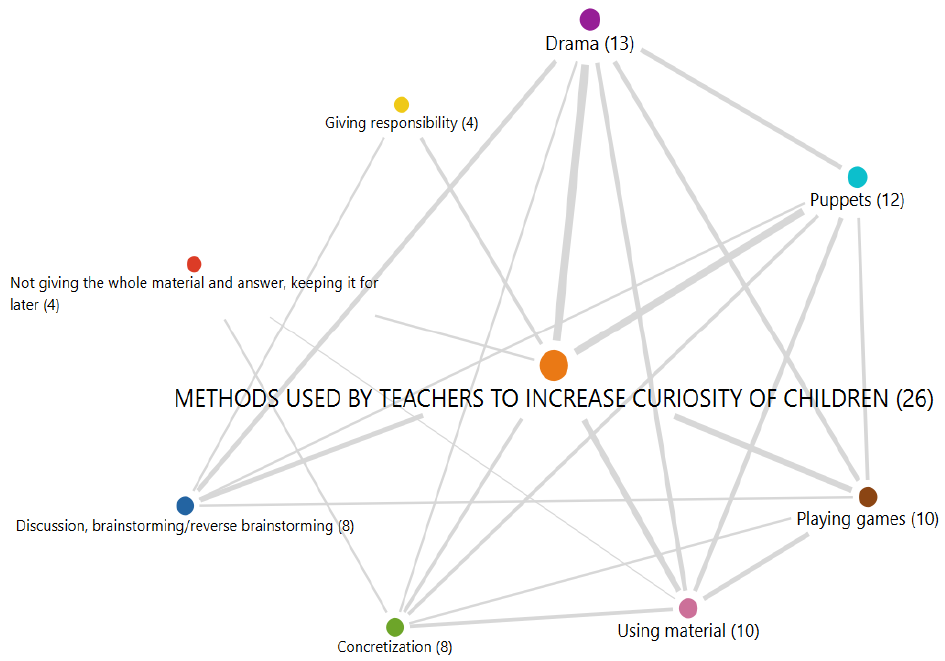
Figure 7. Methods used by teachers to increase the curiosity of preschool children.